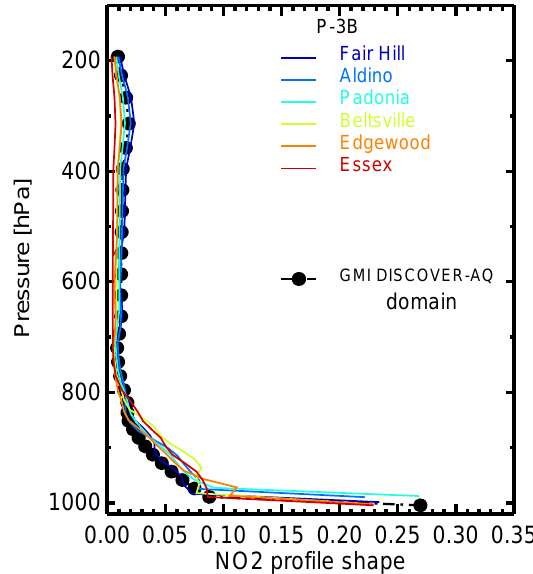
Figure 4. Relative vertical distribution (profile shape) of NO 2 over the six spiral locations during DISCOVER-AQ. The colored lines show the mean profile shapes determined from the in situ mea- surements. The shape factors are calculated as the ratio of partial columns to total tropospheric column. The dashed line with filled circles shows the profile shape calculated from the GMI